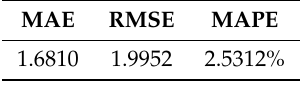
Table 4. Goodness of fit of the